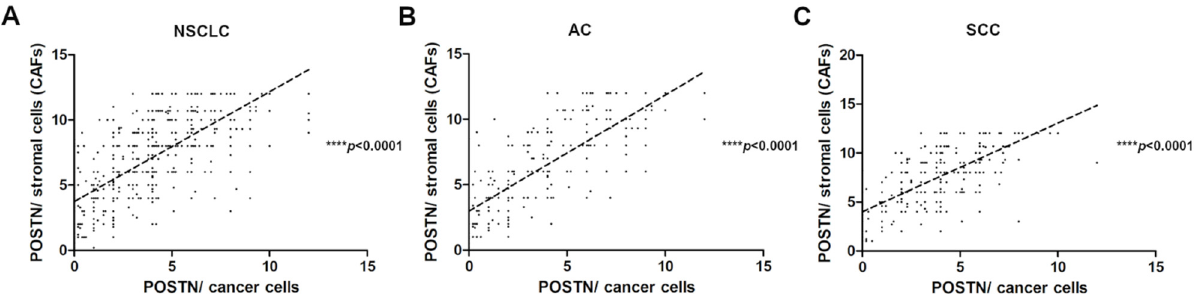
Figure 5. Correlations of periostin (POSTN) expression levels in the cytoplasm of cancer cells with POSTN expression in stromal cells (CAFs) in ( A ) non-small cell lung carcinoma (NSCLC) (r = 0.7085, **** p < 0.0001), ( B ) adenocarcinoma (AC), (r = 0.7897, **** p < 0.0001) and ( C ) squamous cell carcinoma (SCC) (r = 0.6607, **** p < 0.0001).